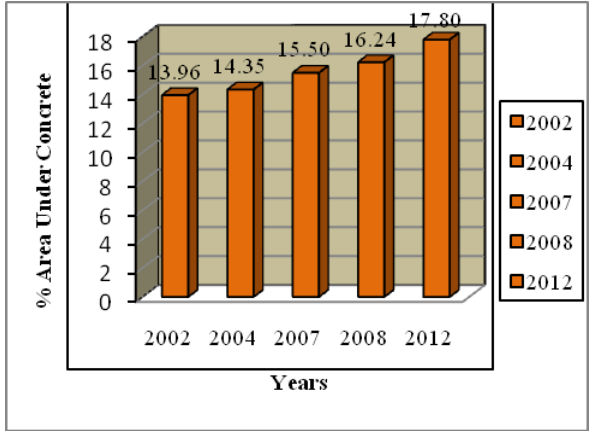
Figure 6. Areas under